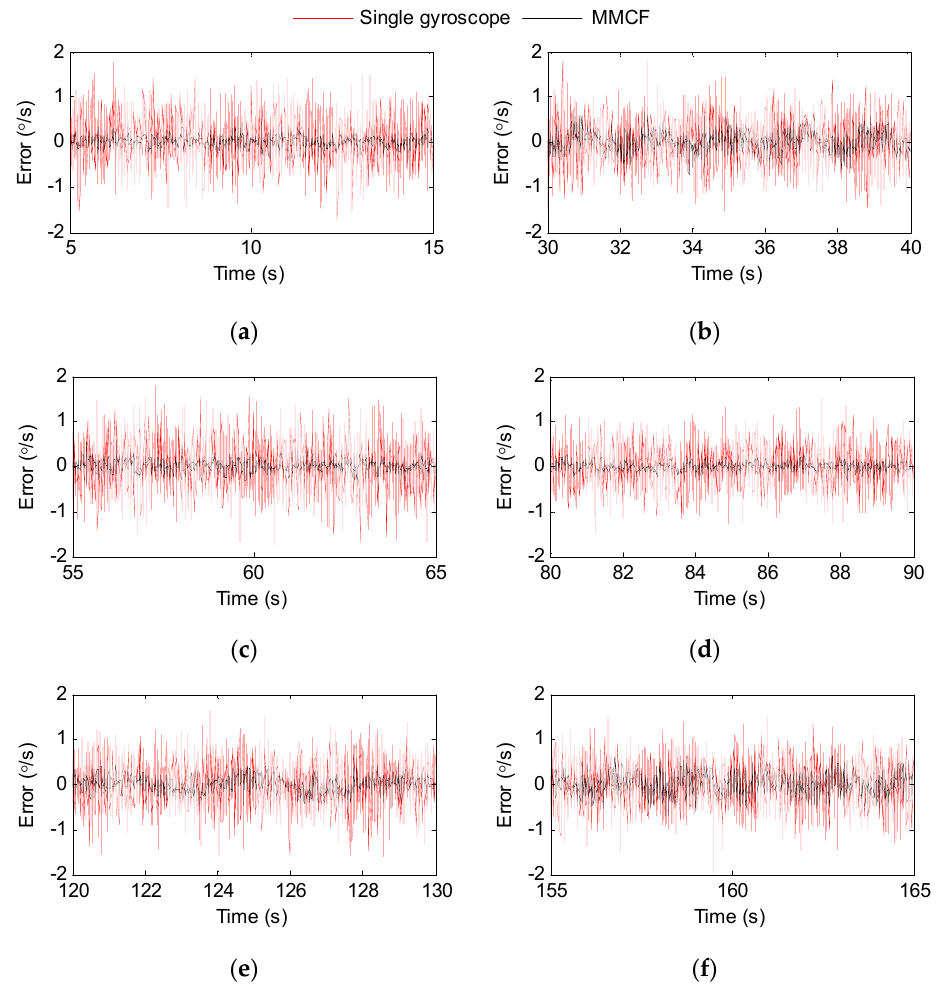
Figure 12. Estimated error with MMCF over different time periods: ( a ) at 5–15 s, the input signal was ω = 0; ( b ) at 30–40 s, the input signal was ω = 10 π sin ( π t ) ◦ /s; ( c ) at 55–65 s, the input signal was